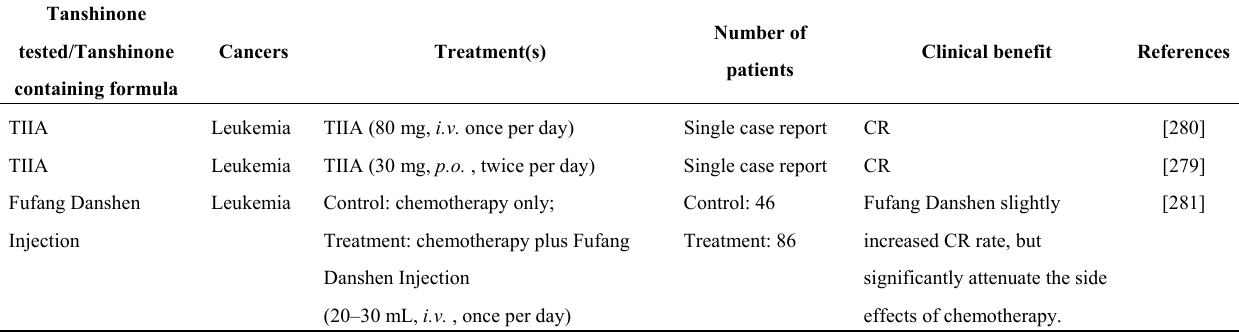
3. Cancer-related clinical studies of tanshinone IIA (TIIA)